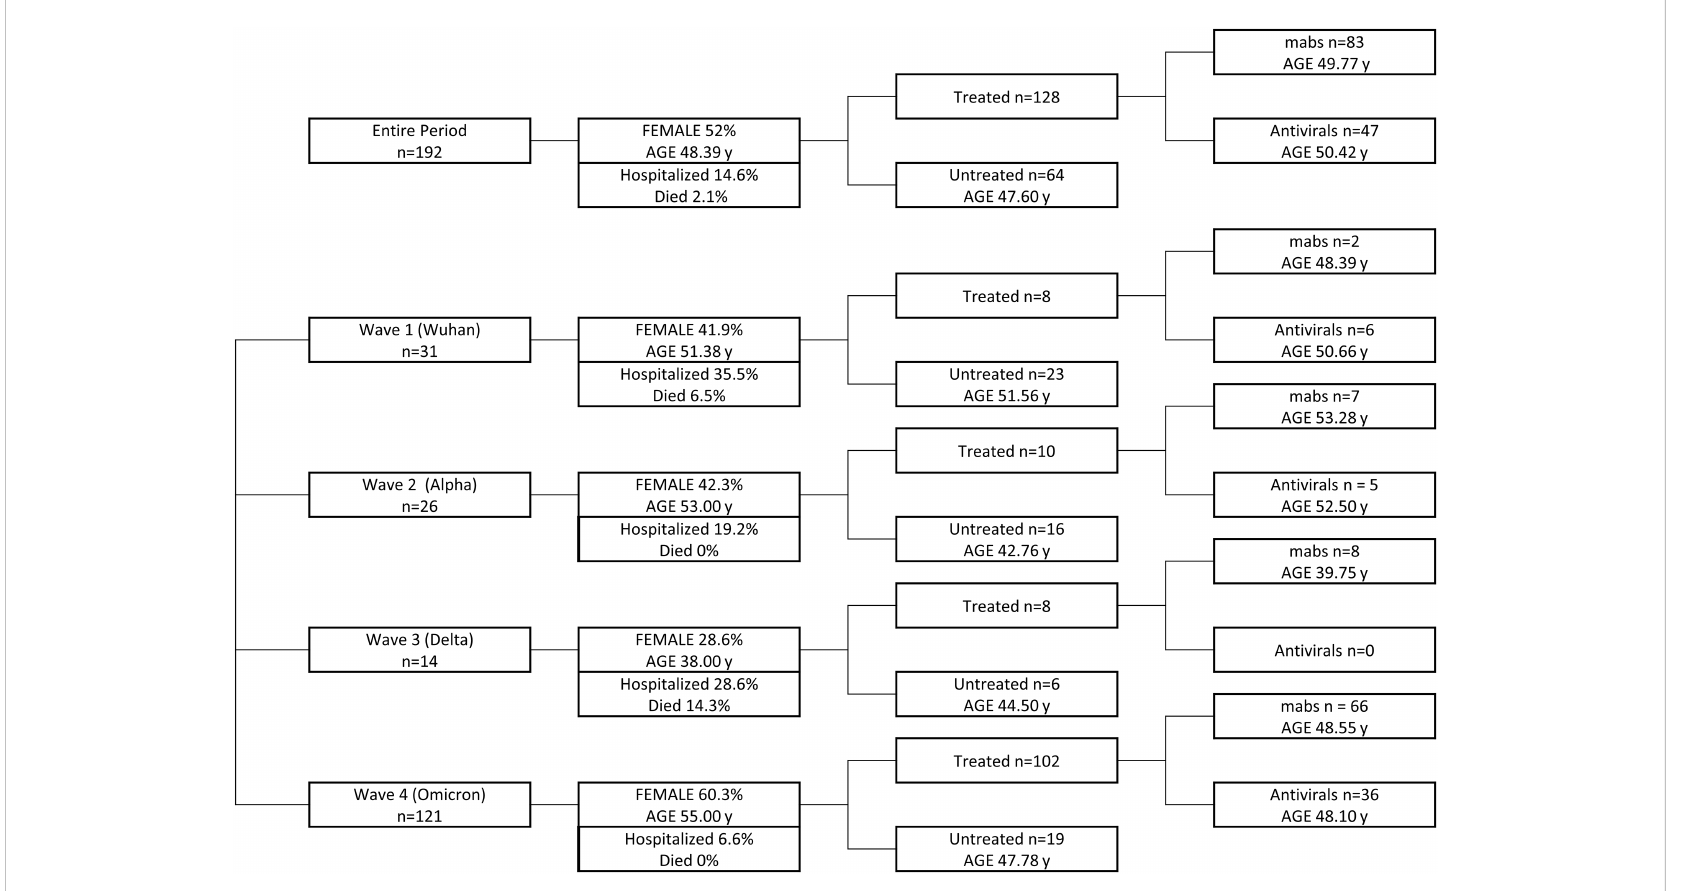
FIGURE 1 Graphical design of the study. Patients infected in the entire period and during each wave are grouped on the basis of the treatment received, taking into account age and sex representation for each